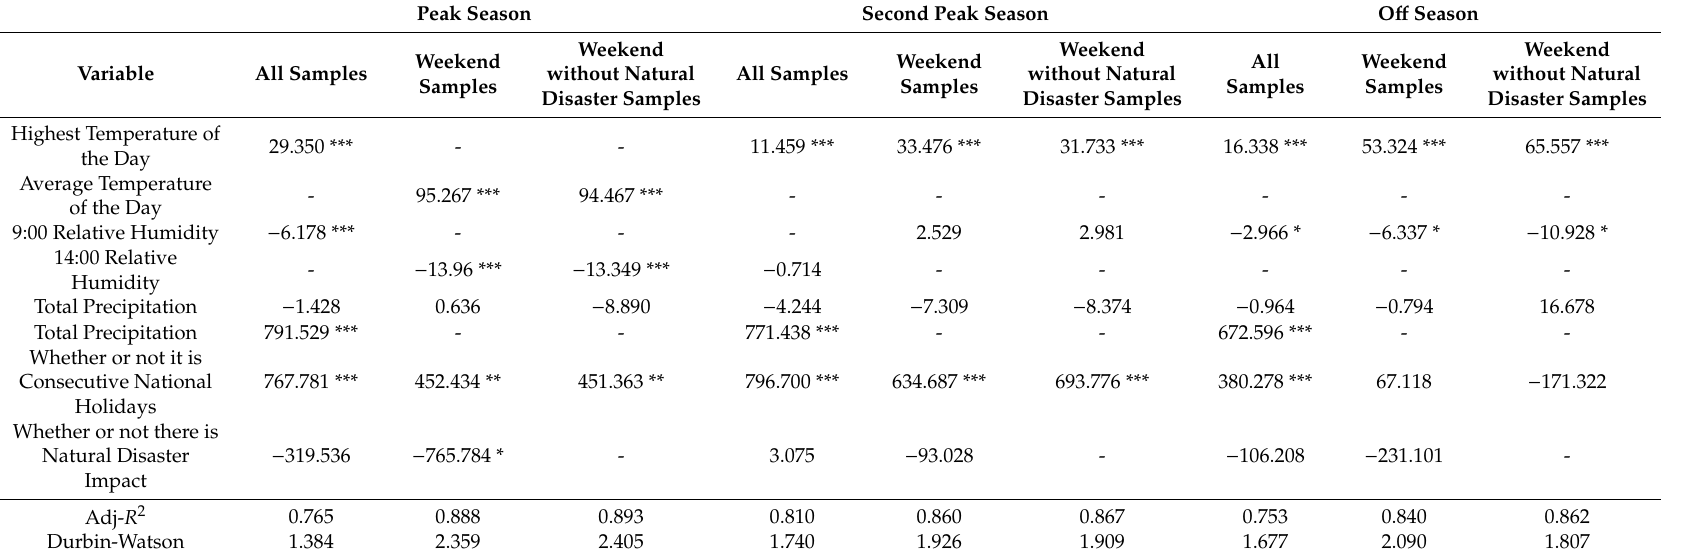
Table 5. Summary of the estimated results for the tourist count impact.